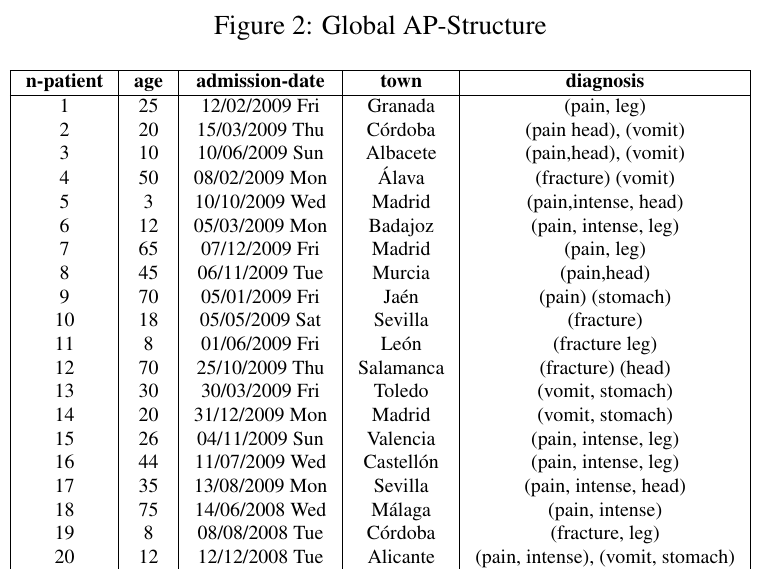
Table 3: Table of the database after the